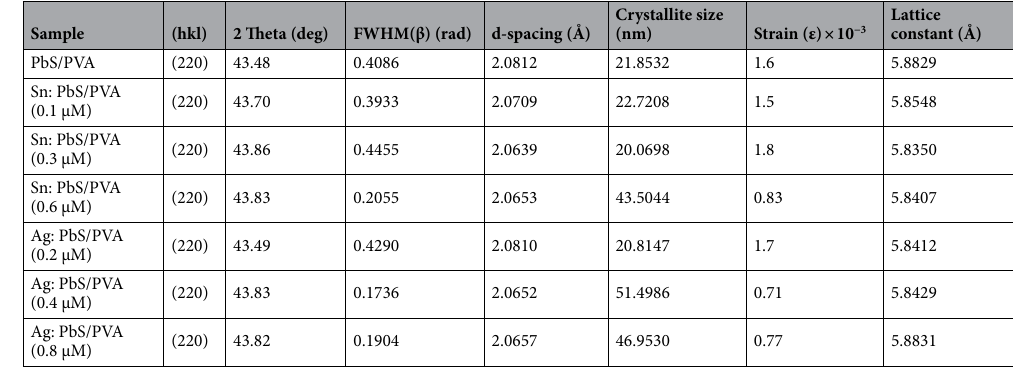
Table 1. Numerical values of PVA/PbS and Sn (Ag) doped PVA/PbS crystal parameters.